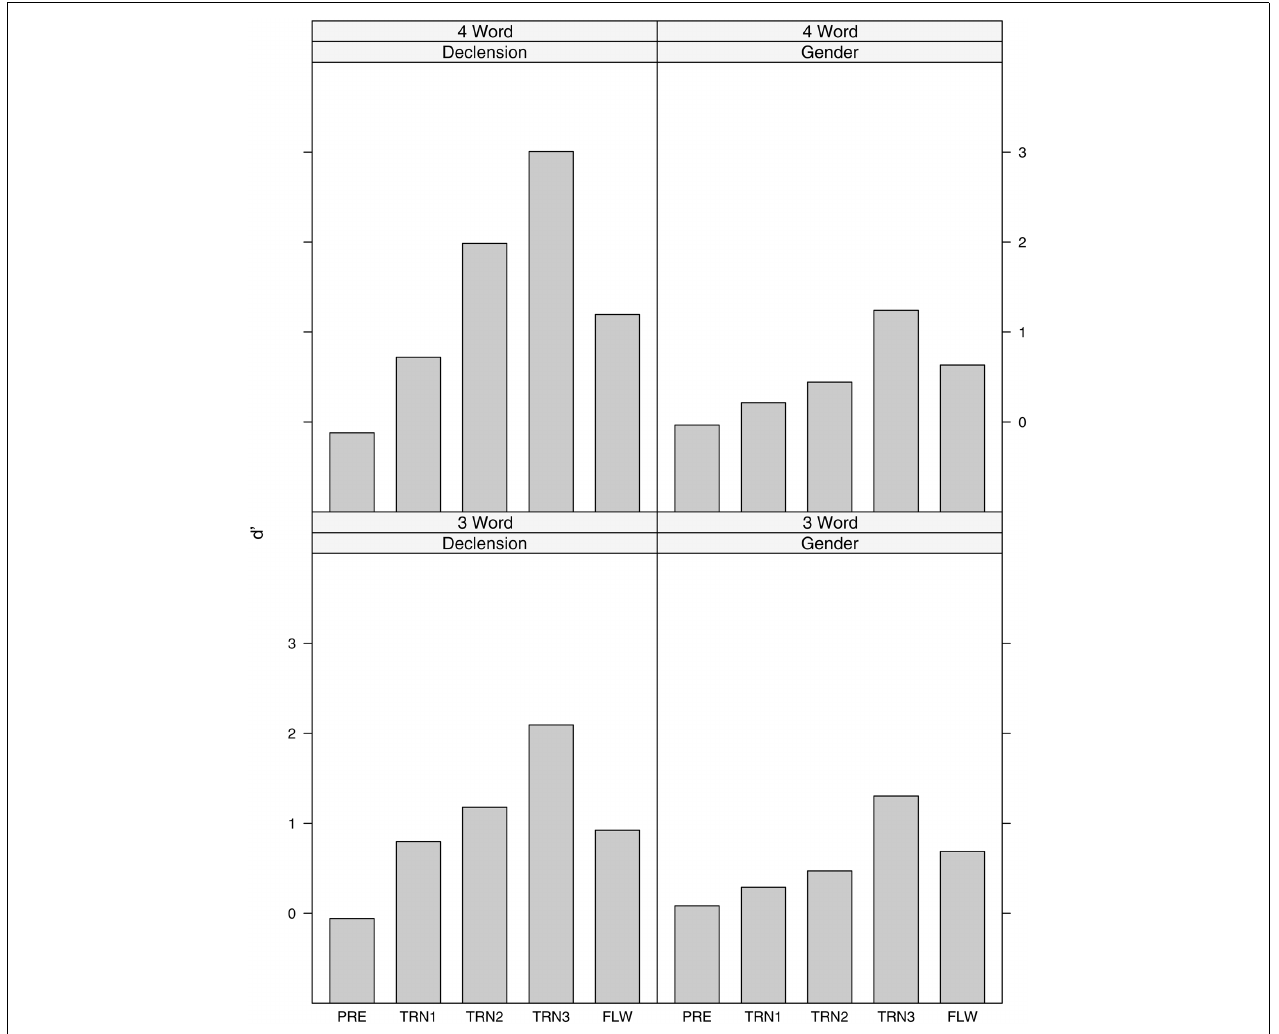
FIGURE 2 |Average classification performance ( d (cid:2) ) over pre-test, training (1–3), and follow-up blocks for the three- and four-word phrases, for the declension and gender